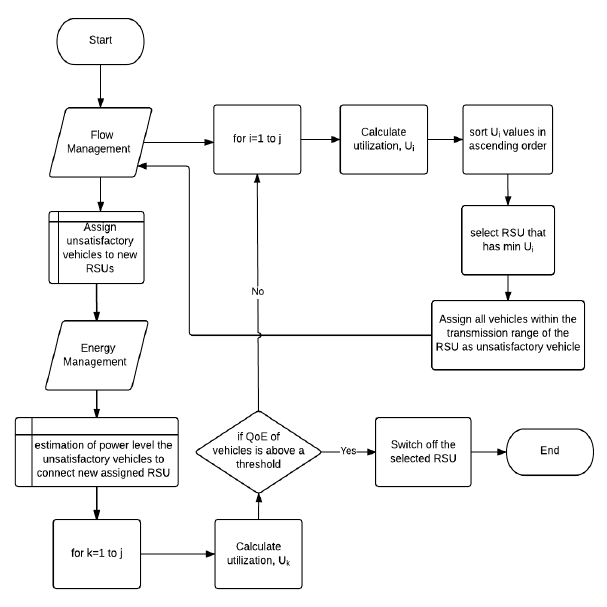
Figure 6. Flow Diagram of Energy Management